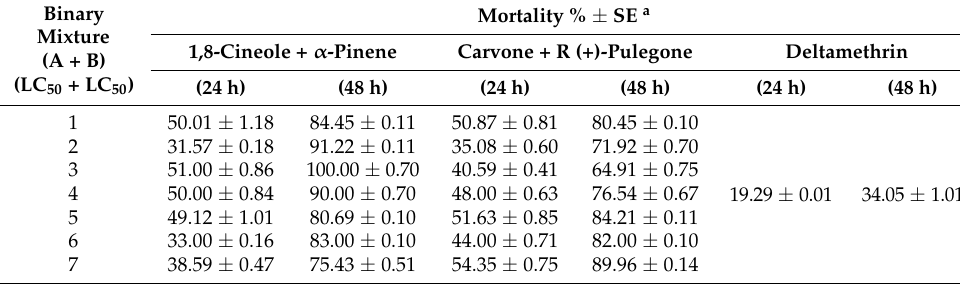
Table 3. Toxicity of the two mixtures against C. pipiens female adults.